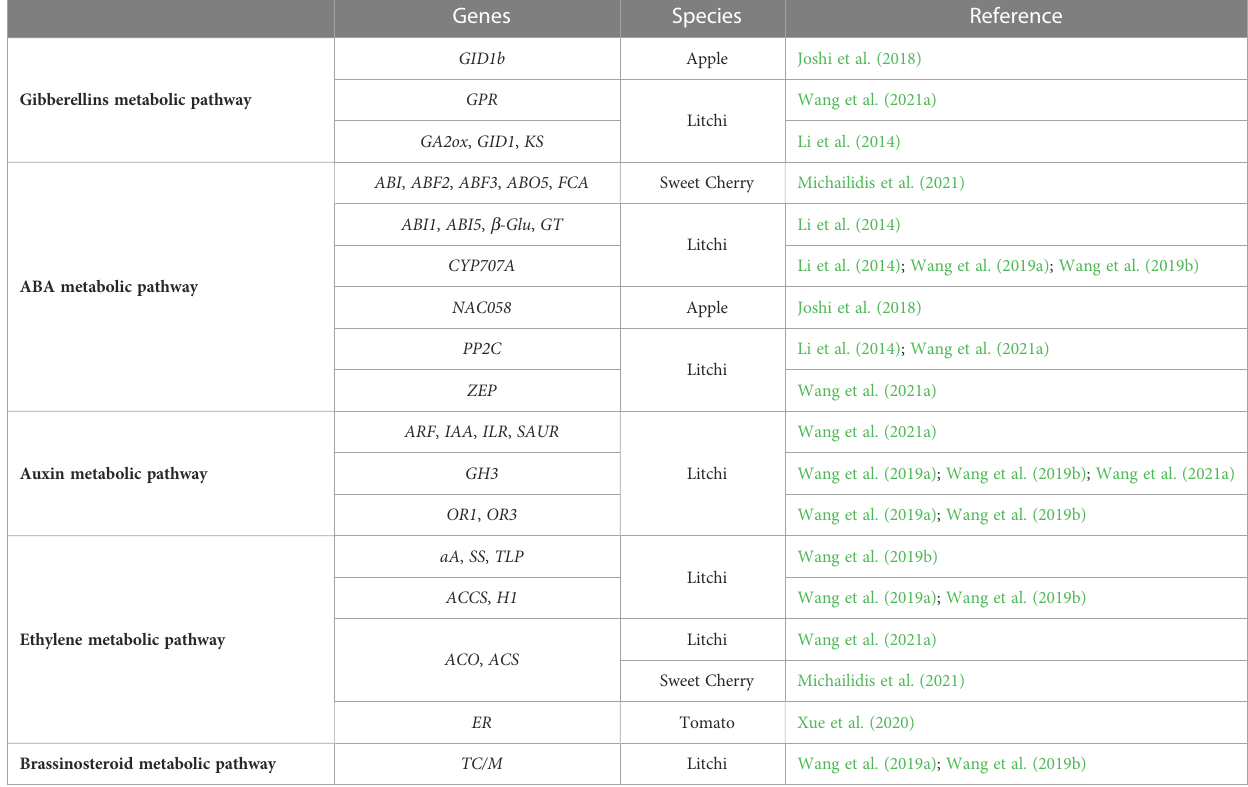
XET3 (Table 1) (Lu et al., 2006). Additionally, the expression of a XET gene is upregulated in fruits without cracks compared to cracked fruits (Li et al., 2014). The expression of two genes encoding expansins in litchi pericarp, Exp1 and Exp2 , appear to have a closely association with fruit growth and cracking, since the expression of both genes is detected from the early stage of fruit rapid growth and then increase and reach to the highest level at the end of the growth phase in pericarp of the cracking-resistant cultivar Huaizhi, while Exp1 gene is detected at the stage of rapid fruit growth, and then increase slightly and fi nally kept almost constant in pericarp of the cracking-susceptible cultivar Nuomici, not being detected expression of Exp2 in this cultivar (Yong et al., 2006). Similar results were obtained by Wang et al. (2021a), whose an upregulation of cell wall related genes ( EXP and b -